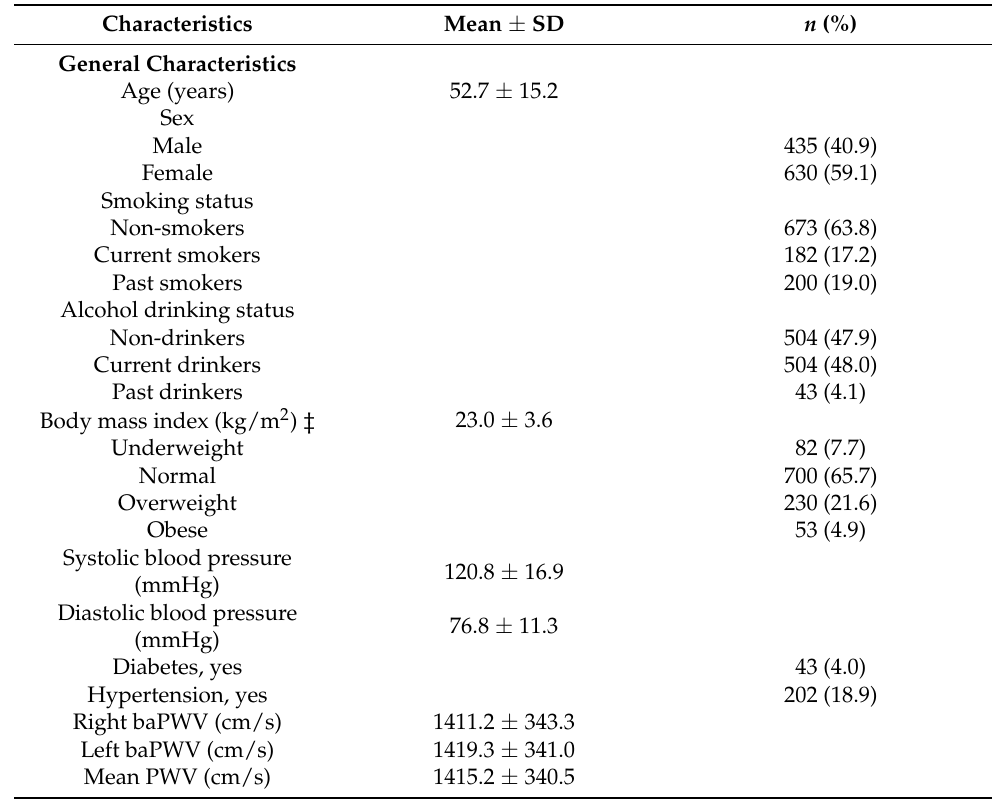
Figure 1. A participants’ flow diagram. Table 1. Basic characteristics of participants ( n = 1065).